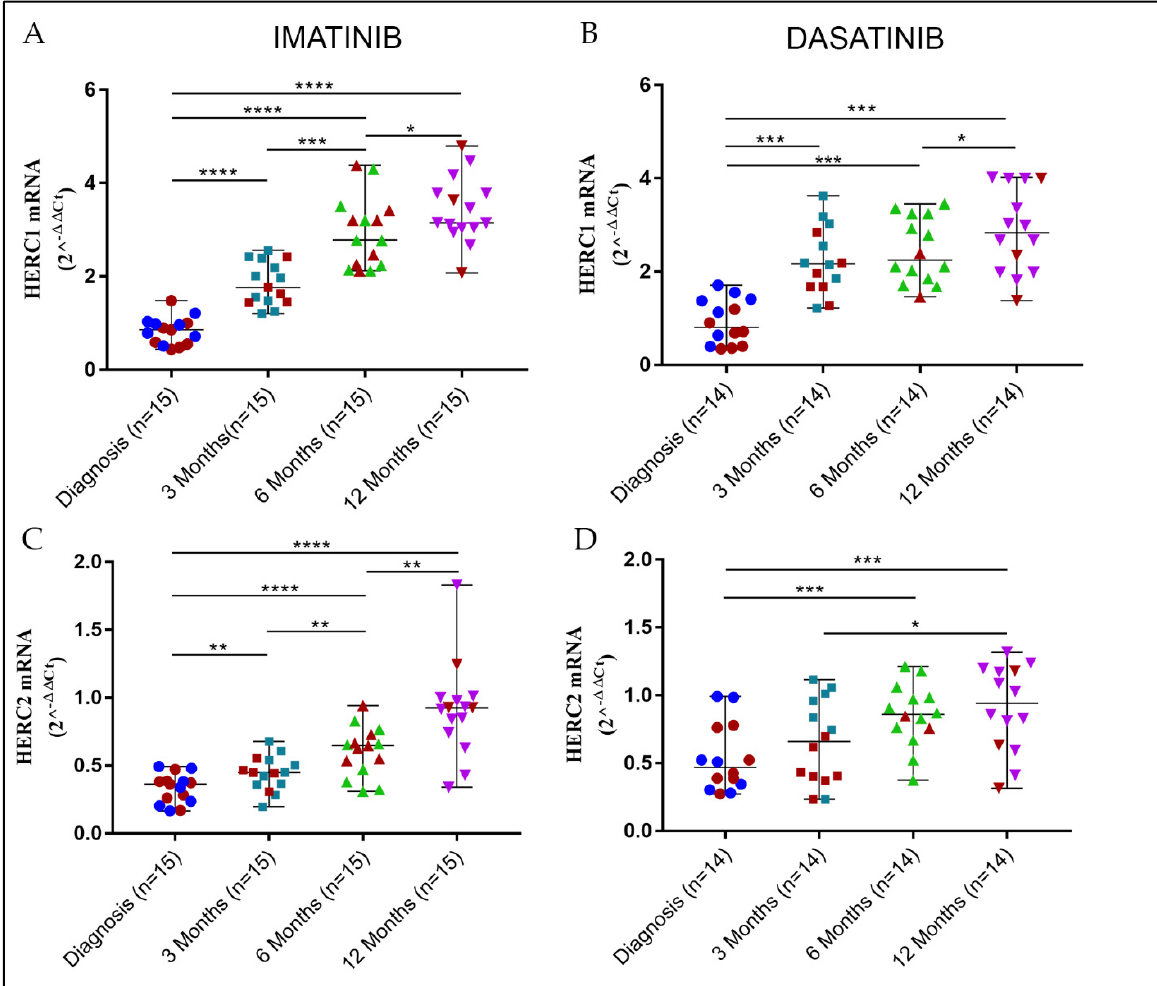
Figure 2. The kinetic evolution of the HERC1 and HERC2 transcript levels in CML patients treated with Imatinib and Dasatinib. Independently from the TKIs therapy regimens, both HERC1 and HERC2 displayed a transcript accumulation kinetic that was rather comparable. In all cases, the gene expression levels increased over the time elapsed from diagnosis to at least the complete cytogenetic remission (12 months), reaching values comparable to those of healthy subjects. While upon Imatinib treatment, the HERC1 ( A ) and HERC2 ( C ) gene transcripts accumulation followed an approximately growing linear trend; with Dasatinib, the HERC1 ( B ) and HERC2 ( D ) accumulation differed substantially, being significantly delayed. Red and different color symbols represent BM and PB, respectively, in each time point of CML specimens. p ≤ 0.05 = *; p ≤ 0.01 = **; p ≤ 0.001 = ***; p ≤ 0.0001 = ****.